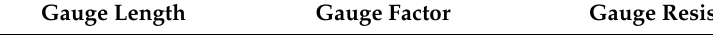
Table 3. Specification of strain gauge.